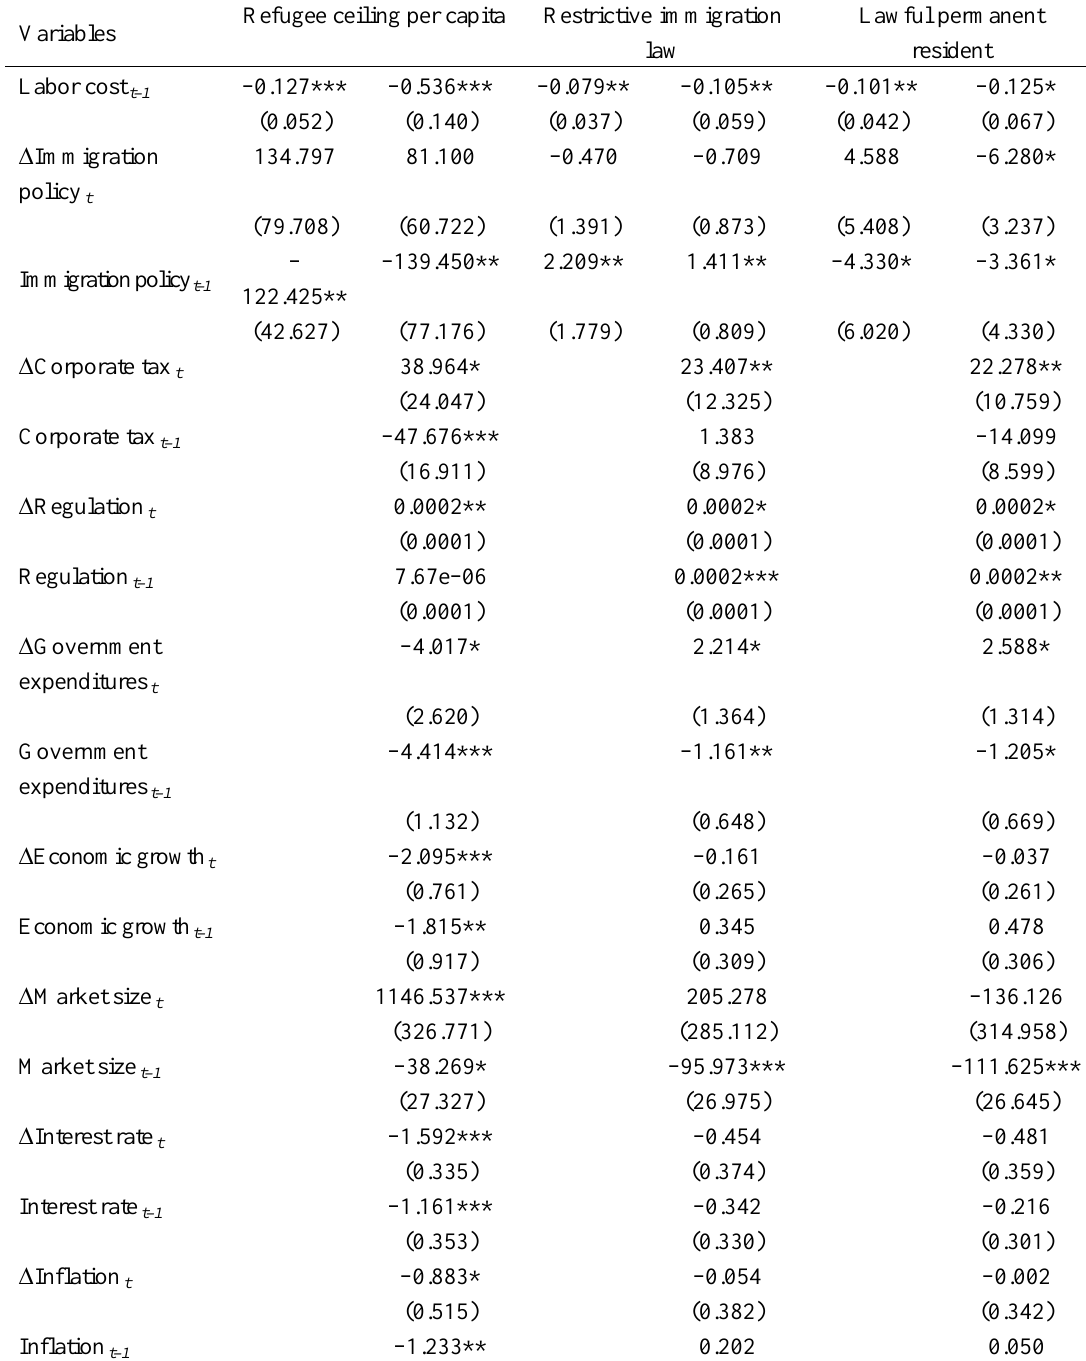
Table 5: The Impact of Immigration Policy on Labor Costs in the